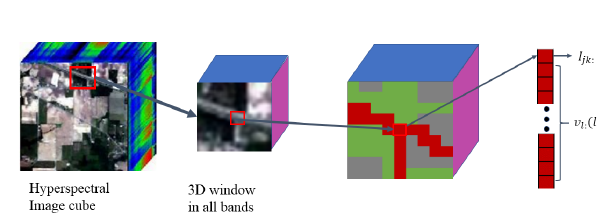
Figure 1. Selecting some similar pixels 3D block around the reference